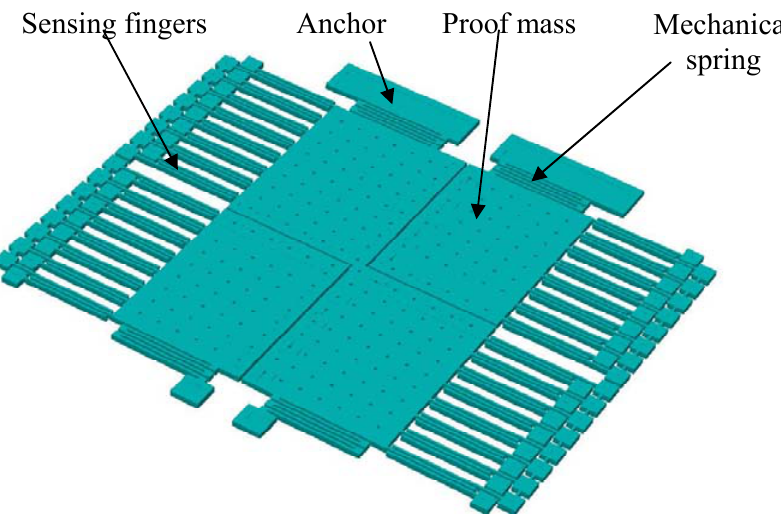
Figure 1. 3-D structural model of the fully differential accelerometer.